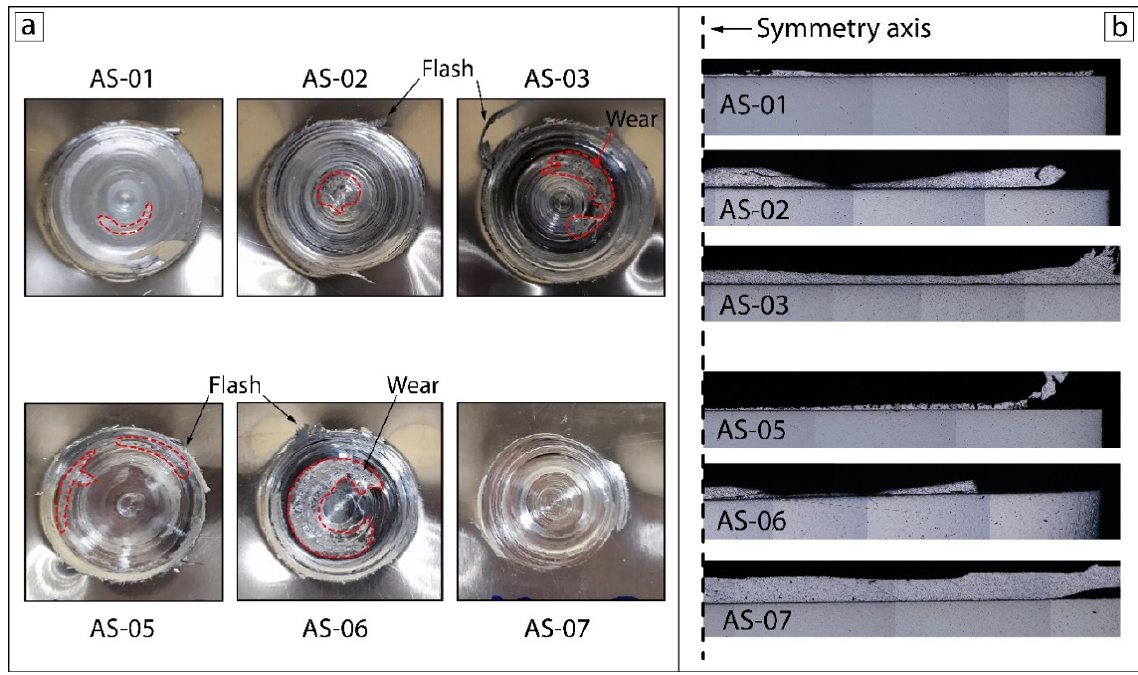
Figure 3. The upper-surface appearances ( a ) and cross-sections ( b ) of P-FSSW samples. The degree of material softening was affected by the duration of the process at a certain temperature. The higher temperature generated at 1500 RPM coupled with both load forces of 7350 N and 4900 N was responsible for an excessive heat input with a great softening and distortion of the upper AA2024 plate, which also matched the equivalent stress result owing to fast material heating. A combination of the highest rotation speed (2000 RPM) and both cases of tool force produced the thinning of the upper plate in samples AS-01 and AS-05. Detailed images show that there were no refined grains (Figure 4). The samples made at the lowest rotation speed (1000 RPM) had a good metallurgical bonding due to the reduction in the heat input per unit length and lower dissipation of heat over a wider region of the workpieces, which made the heating slow and appropriate. The difference in the tool axial force was responsible for a large gap in the flash volume of samples AS-03 and AS-07. The higher amount of flash in sample AS-03 was due to stronger tool penetration into the workpiece, which was also demonstrated by the numerical